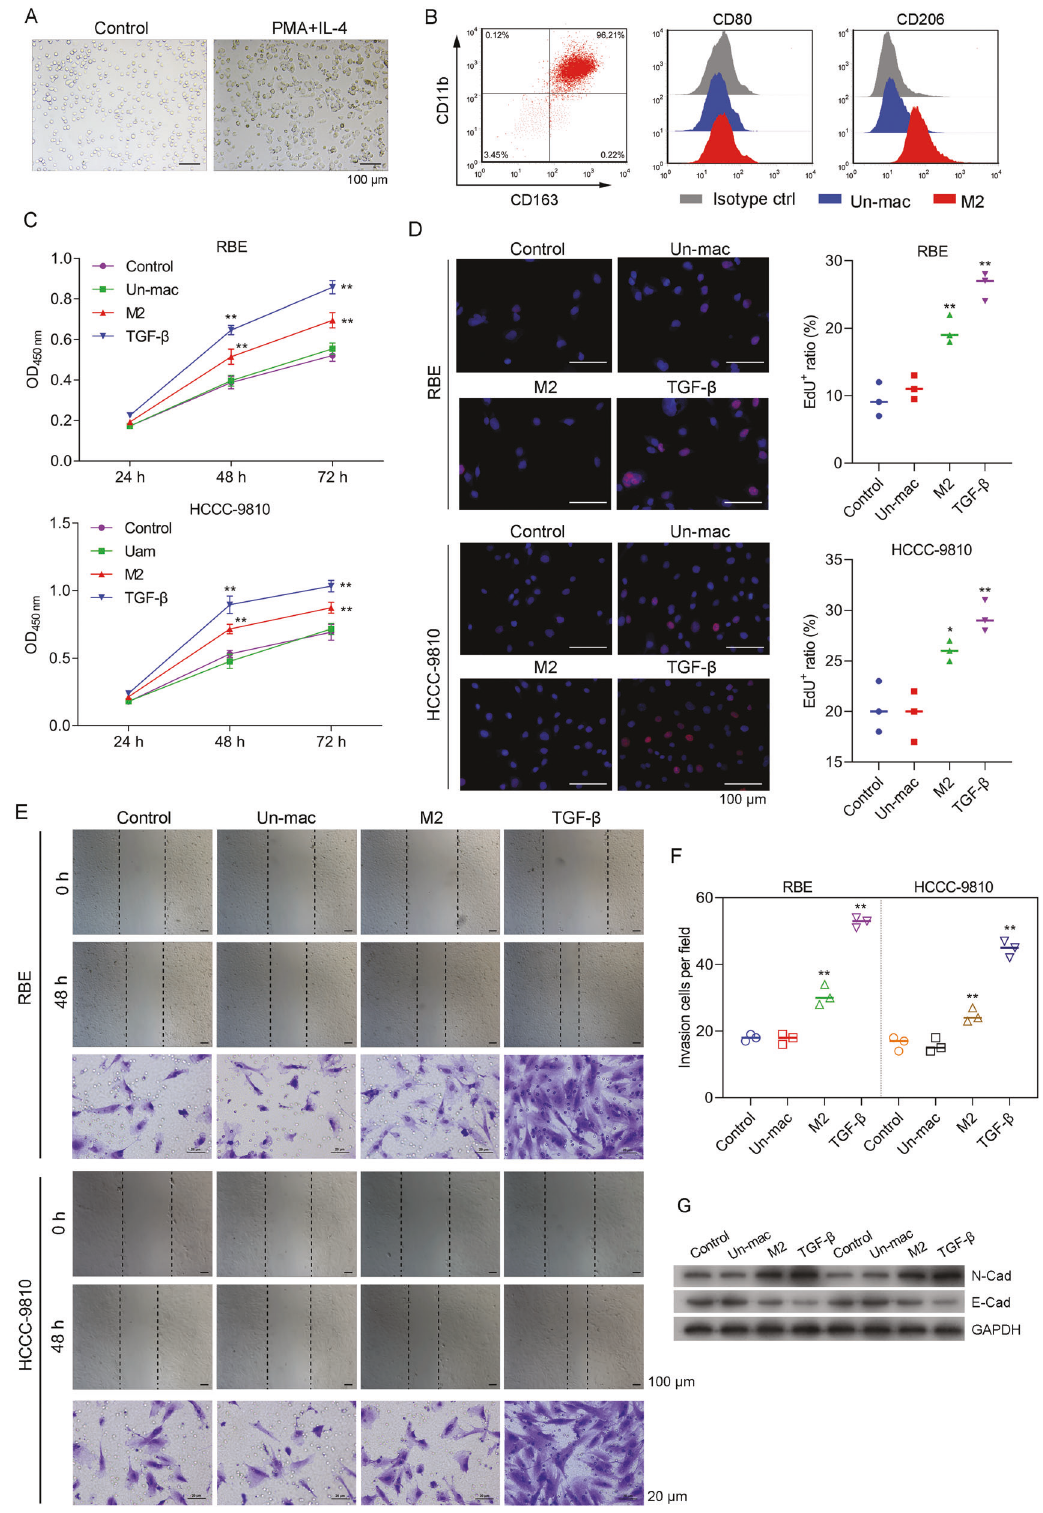
Fig. 1 TAMs promoted CCA cell proliferation, migration, and invasion. A THP-1 cells were treated with PMA (100 ng/mL) + IL-4 (20 ng/mL) to induce macrophage differentiation. B Differentiated THP-1 cells were collected and stained with the indicated antibodies for subsequent fl ow cytometry analysis. C RBE cells (upper panel) and HCCC-9810 (lower panel) cells were co-cultured with M2 macrophages (M2), untreated THP-1 cells (Un-mac), or treated with TGF- β . After 24, 48, and 72 h, CCK8 solution was added to the cells and the absorbance at 450 nm was measured. D The respective images of Edu staining assays and a summary of results from three different experiments are shown. E Cell monolayers were wounded and images were acquired at 0 and 48 h. The respective images of Transwell assays are shown (lower panel). F Results of cell invasion assays as summarized from three independent experiments. G Cells were treated as described above and lysed for western blot assays. * p < 0.05 and ** p < 0.01 compared with the control group. Cell Death and Disease (2022)